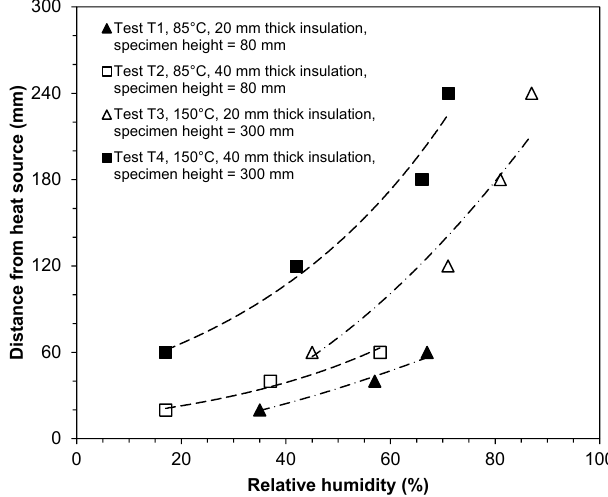
Figure 6. Relative humidity profiles in the non-isothermal tests at 85 °C and 150 °C with various thicknesses of insulation.